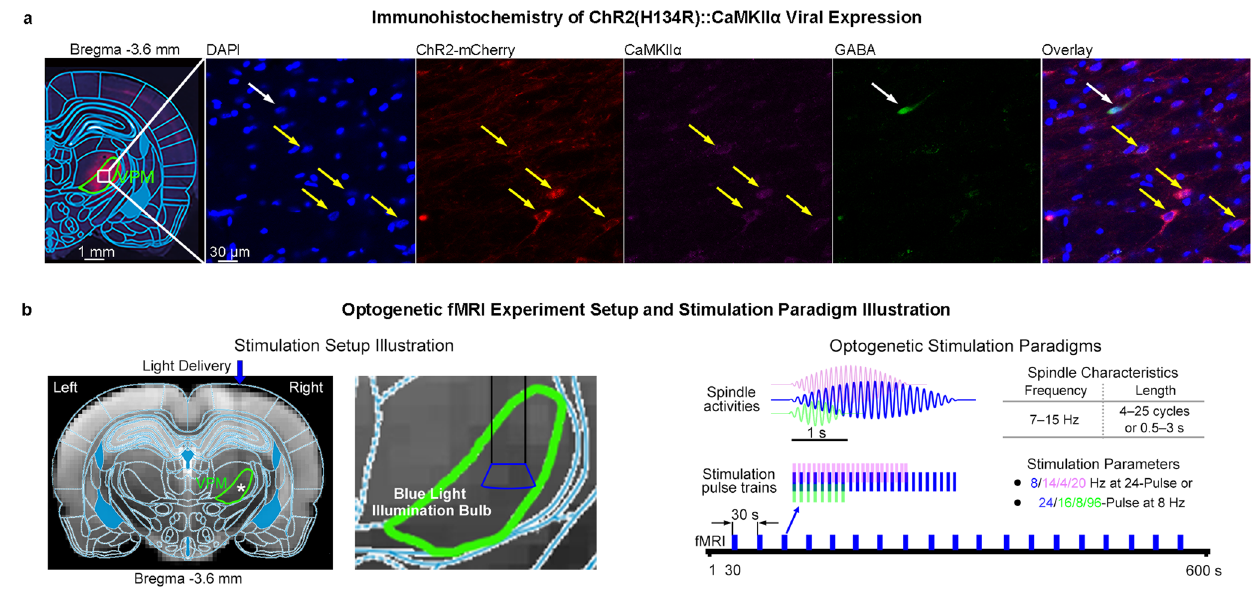
Fig. 1 | Histological characterization of ChR2::CaMKII α viral expression in ventral posteromedial (VPM) thalamocortical excitatory neurons and opto- genetic fMRI experiment setup and stimulation paradigms. a Confocal images of ChR2-mCherry expression in VPM with lower (Left) and higher (Right) magni fi - cation.Overlayofimagesco-stainedforthenuclearmarkerDAPI,excitatorymarker CaMKII α , inhibitory marker GABA, and ChR2-mCherry revealed colocalization of ChR2-mCherryandCaMKII α inthecellbodyofthalamocorticalexcitatoryneurons (indicatedbyyellowarrows),notGABAergicinhibitoryneurons(indicatedbywhite arrows). b T2-weighted anatomicalMRIimage shows thelocation oftheimplanted